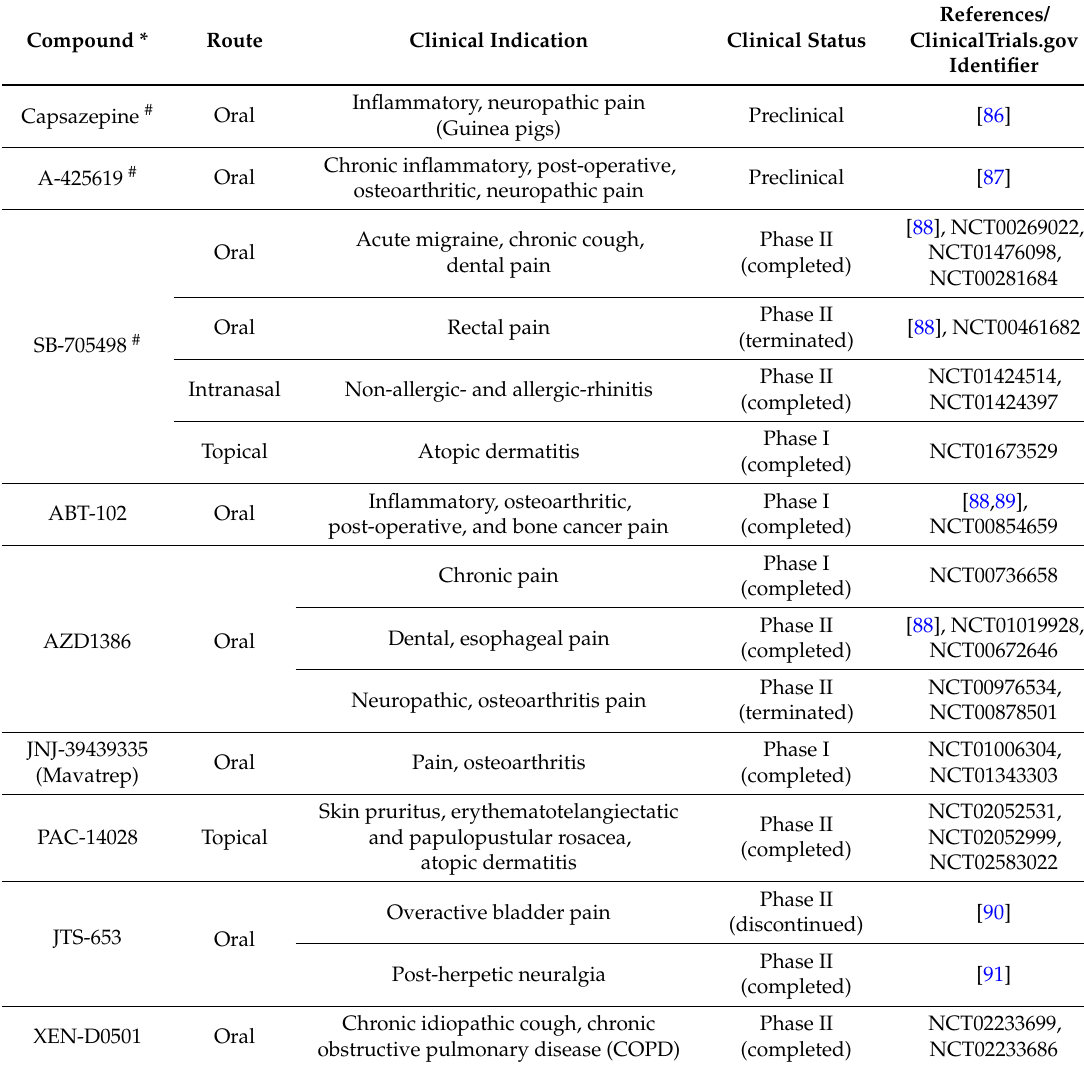
Table 2. Clinical status of capsaicin-derived- and capsaicin-targeted-antagonists in